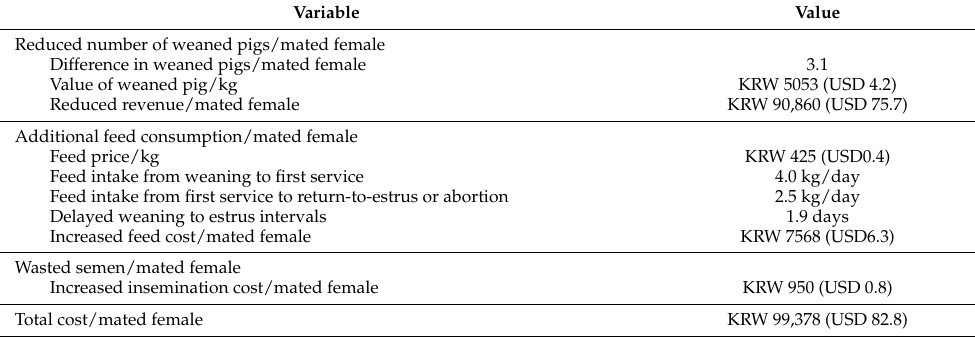
Table 3. The economic impact of PRRS on the breeding-farrowing production phase.